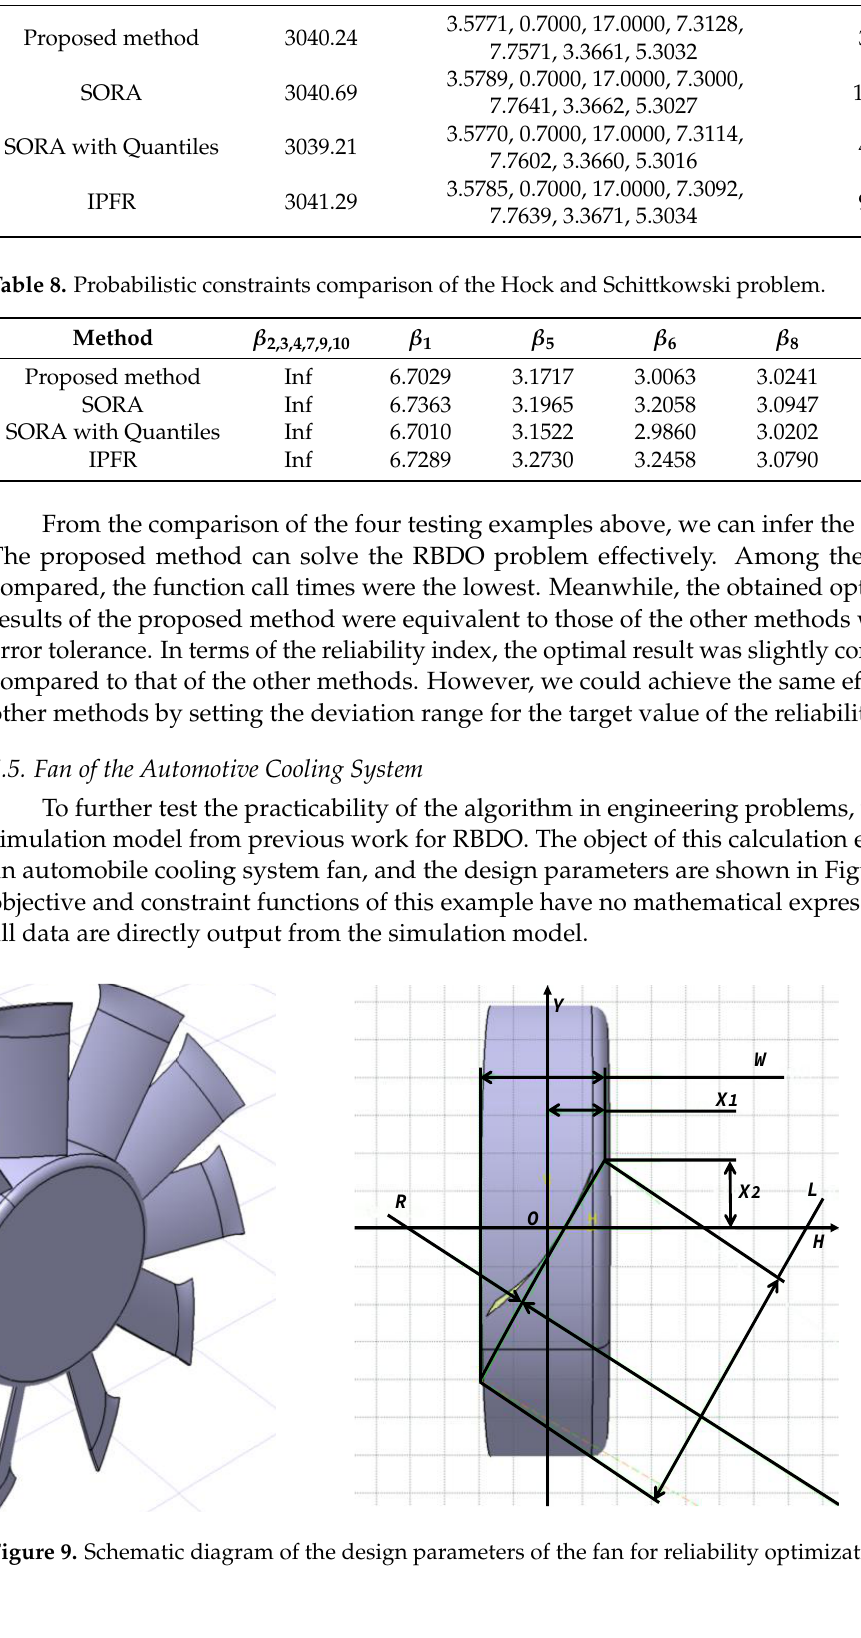
Table 8. Probabilistic constraints comparison of the Hock and Schittkowski problem.